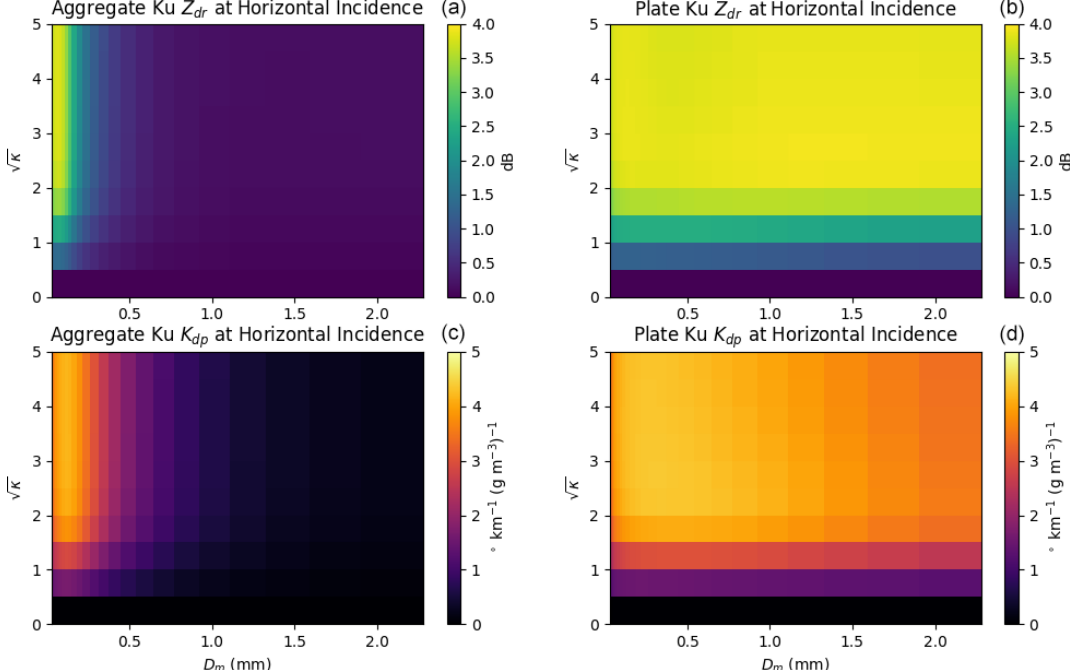
Figure 4. Polarimetric variables Z dr (a, b) and K dp (c, d) as a function of mean particle size D m and orientation distribution parameter κ . Panels (a, c) represent aggregates, and (b, d) individual plates. All values are for horizontal incidence at the Ku band at